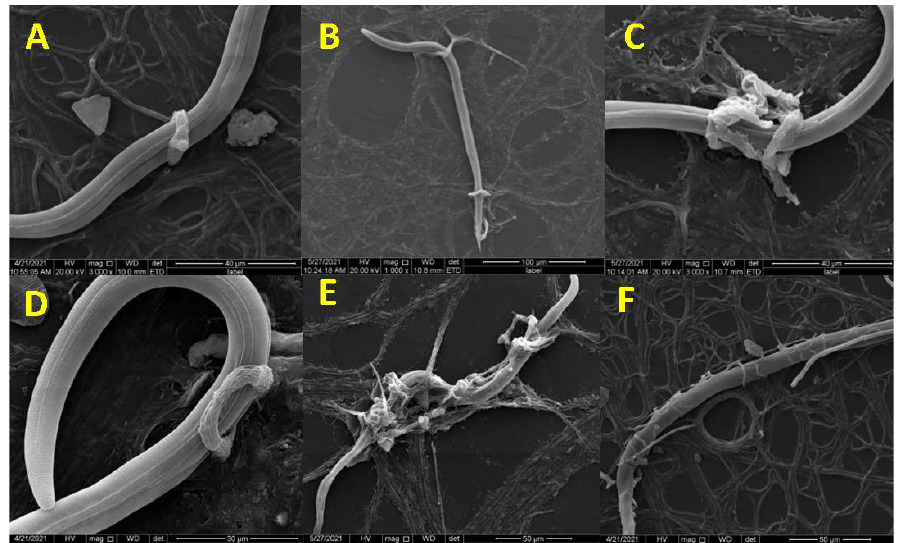
Figure 2. The pathogenicity process of D. flagrans against M. incognita . ( A ) The nematode was trapped by one loop; ( B ) The nematode was trapped at different portions; ( C ) The expanded three-dimensional network; ( D ) The nematode was adhered at the surface of the trap; ( E ) The dead nematode; ( F ) The nematode was twined by mycelia.